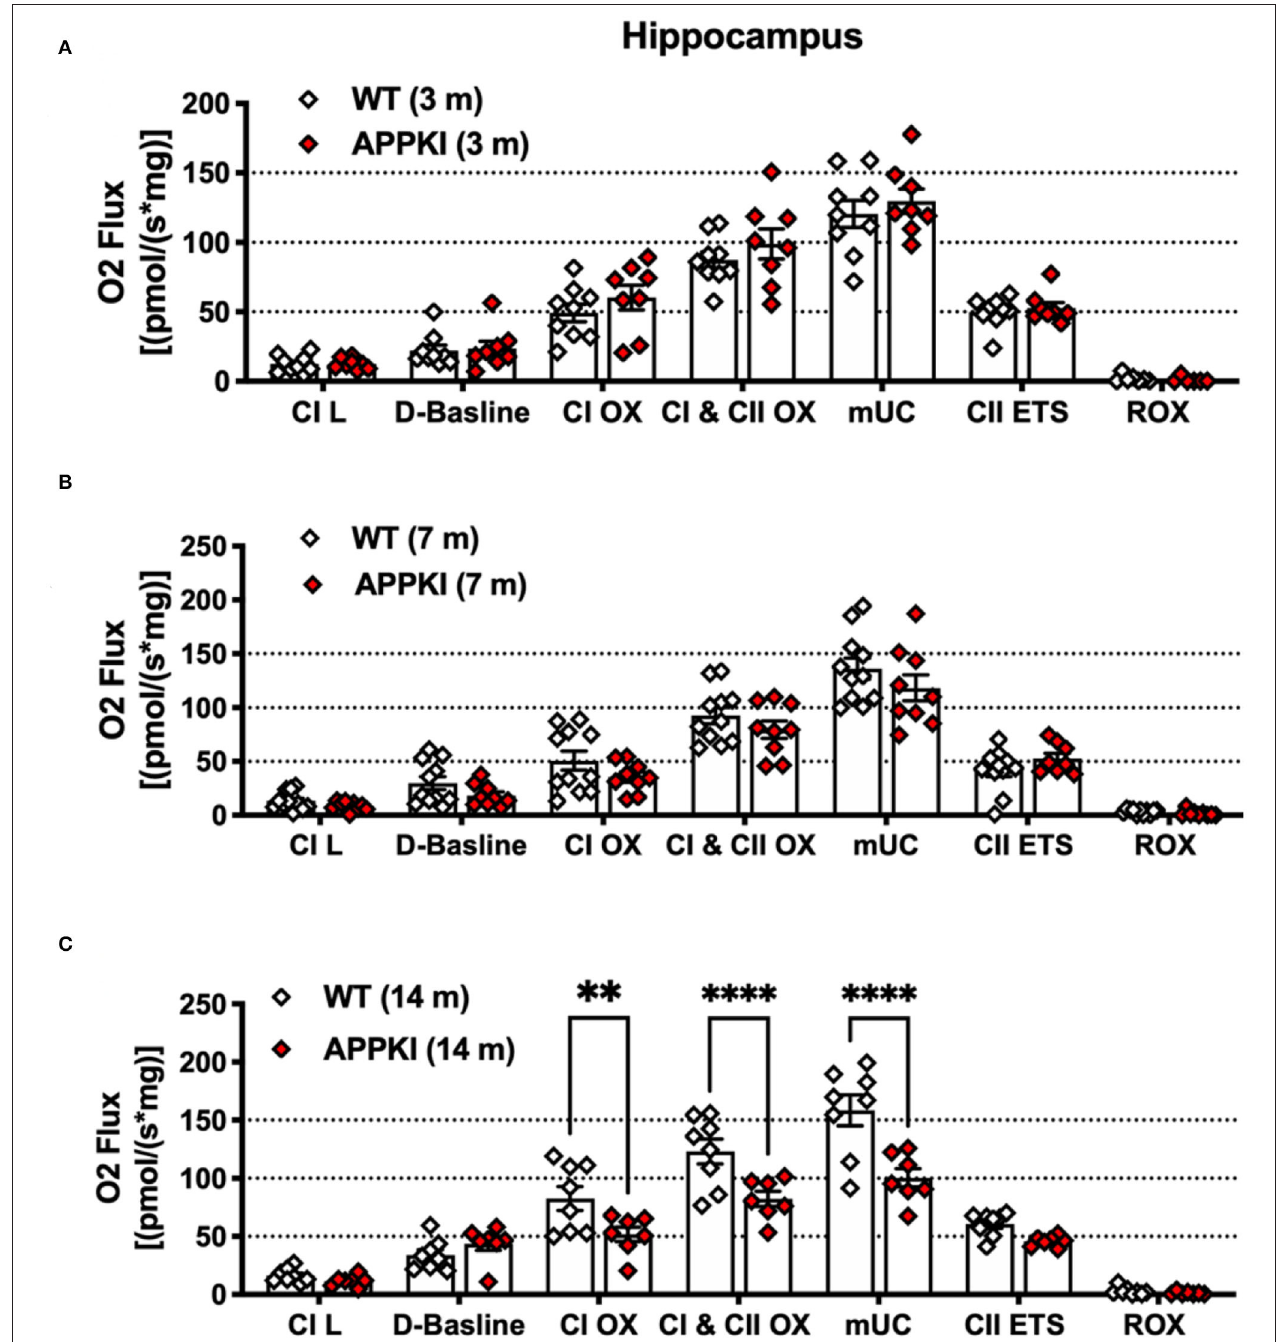
FIGURE 5 | Mitochondrial respiration was decreased in 14-m APPKI hippocampal tissue. (A–C) Quantification of mass-specific oxygen flux from 3-m, 7-m, and 14-m APPKI and age-matched WT mice hippocampal homogenates. The horizontal bar denotes the respiratory states; L: Leak. Data are presented as mean ± SEM; n = 6–11 mice per group. Data were analyzed using one-way analysis of variance (ANOVA) followed by Bonferroni’s multiple comparison test. Significance was assumed when p < 0.05. ** p < 0.01, **** p < 0.001. compared with age-matched WT mice ( Figure 5B ), while 14- observed in complex I-driven (CI OX) respiration ( p = m APPKI hippocampal lysate displayed significantly decreased 0.1041), maximal oxidative phosphorylation (CI and CII OX, mUC ( p = 0.04) compared with age-matched WT mice p = 0.1569), and maximum uncoupled capacity (mUC, p = 0.0576) in response to FCCP titration in APPKI mice ( Figure 5C